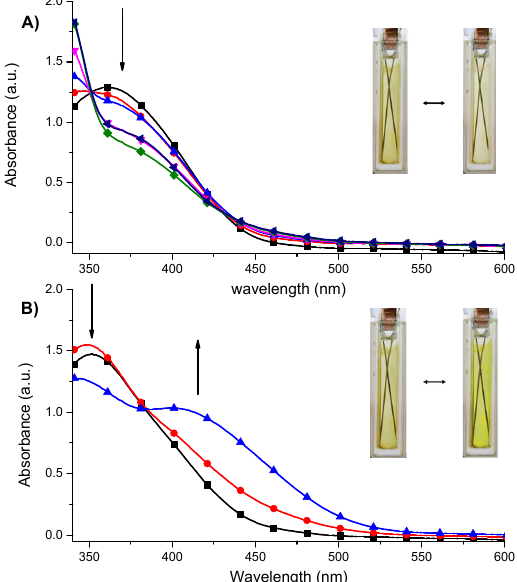
Figure 7. Spectroelectrochemistry of poly-1 immobilized on ITO electrode measured in anhydrous and deaerated 0.1 M solution of TBAClO 4 in acetonitrile as a supporting electrolyte with applied potentials of ( A ) 0 ( ■ ), +500 ( ● ), +600 ( ▲ ), +700 ( ▼ ), +800 ( ◄ ) and +900 ( ♦ ) mV held for 30 s per potential; insert: the photograph of poly-1 in its neutral (left) and electrochemically oxidized (right) states; ( B ) − 100 ( ■ ), − 200 ( ● ) and − 300 ( ▲ ) mV held for 30 s per potential; insert: the photograph of poly-1 in its neutral (left) and electrochemically reduced (right) states.